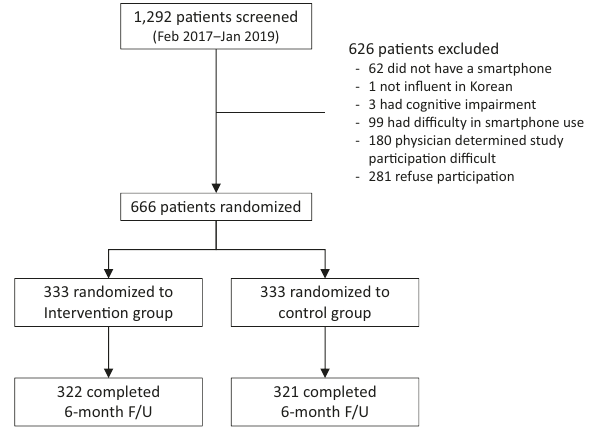
Fig. 1 CONSORT study fl ow diagram. The diagram indicates the number of patients screened, enrolled, and randomized in the trial, and the study fl ow.